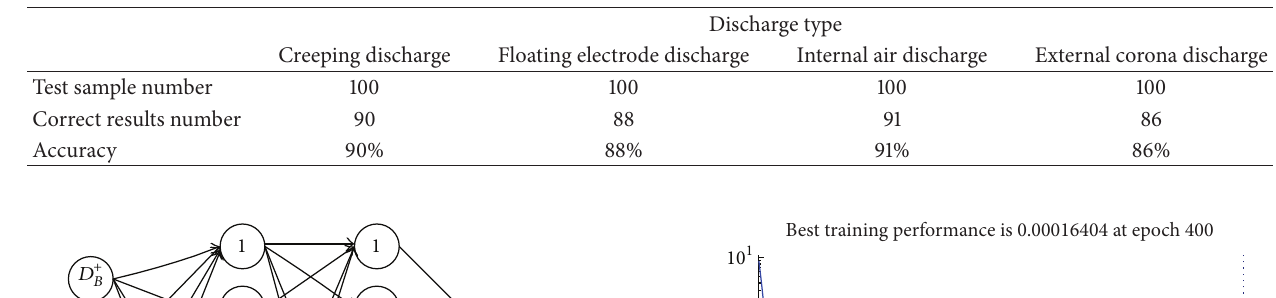
Table 10: Results of ELM.